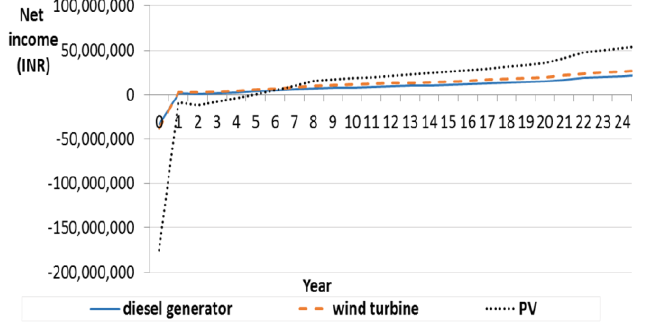
Figure 5. Net income of individual projects to undergo taxation.